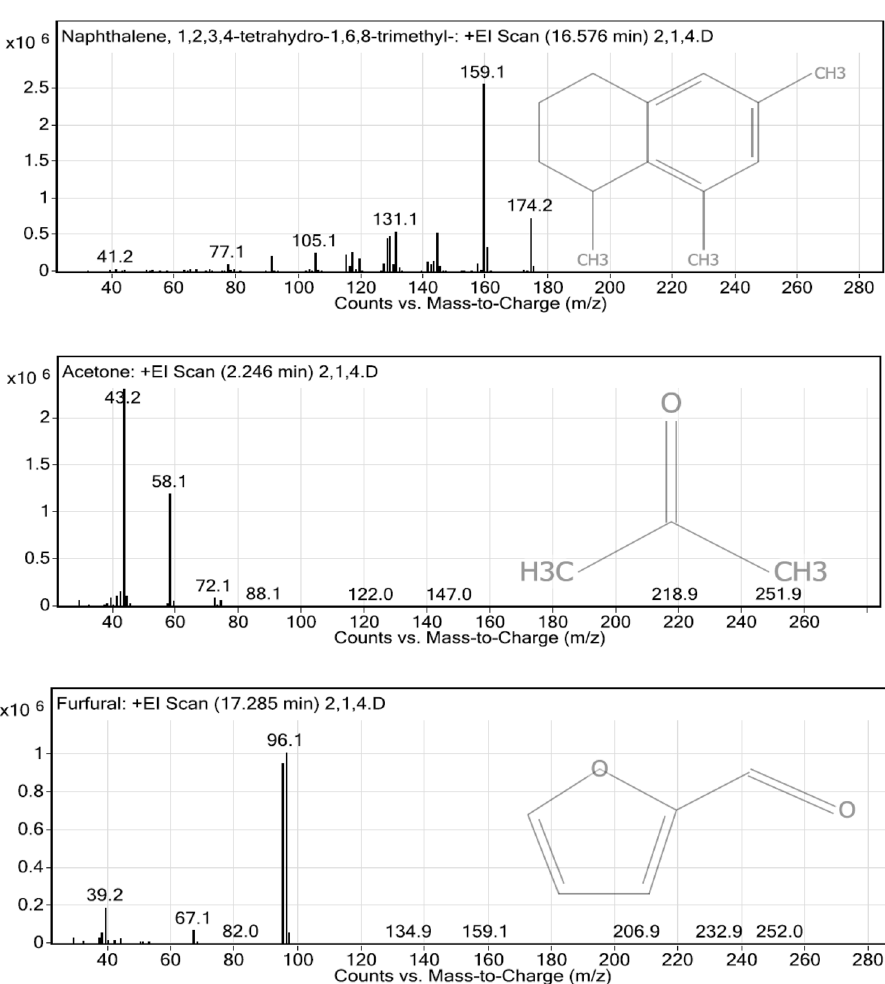
Figure 5. The most abundant volatile organic matters from boiled rice straw followed by enzymatic